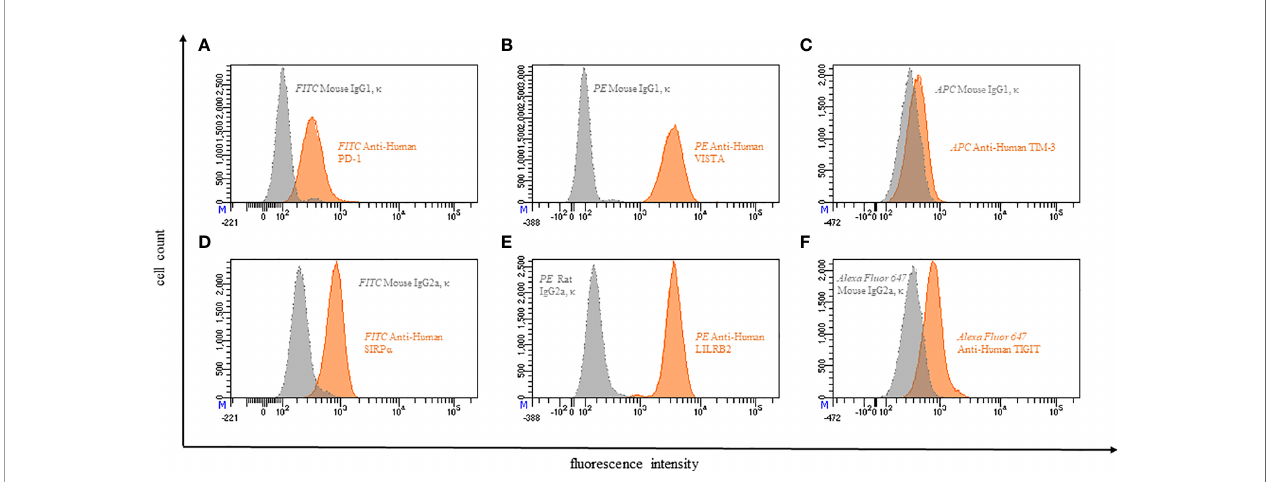
FIGURE 4 | Representative fl ow cytometric analysis of the expression of immune checkpoints (orange): PD-1 (A) , VISTA (B) , TIM-3 (C) , SIRP a (D) , LILRB2 (E) , TIGIT (F) on resting neutrophils of a healthy donor compared with isotype control